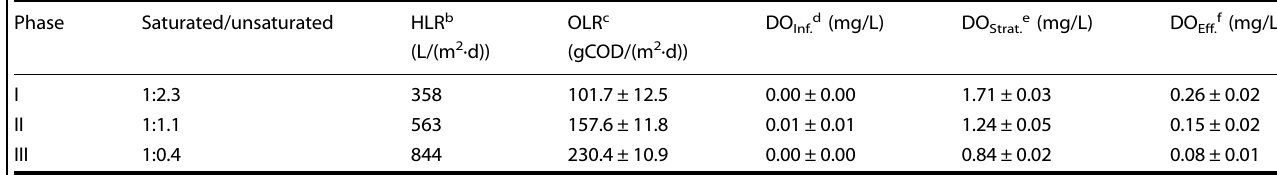
Table 1. Operation conditions of the BhGAC-DBfR a and the dissolved oxygen dynamics for all Phases. Phase Saturated/unsaturated HLR b OLR c DO Inf.d (mg/L) DO Strat.e (mg/L)